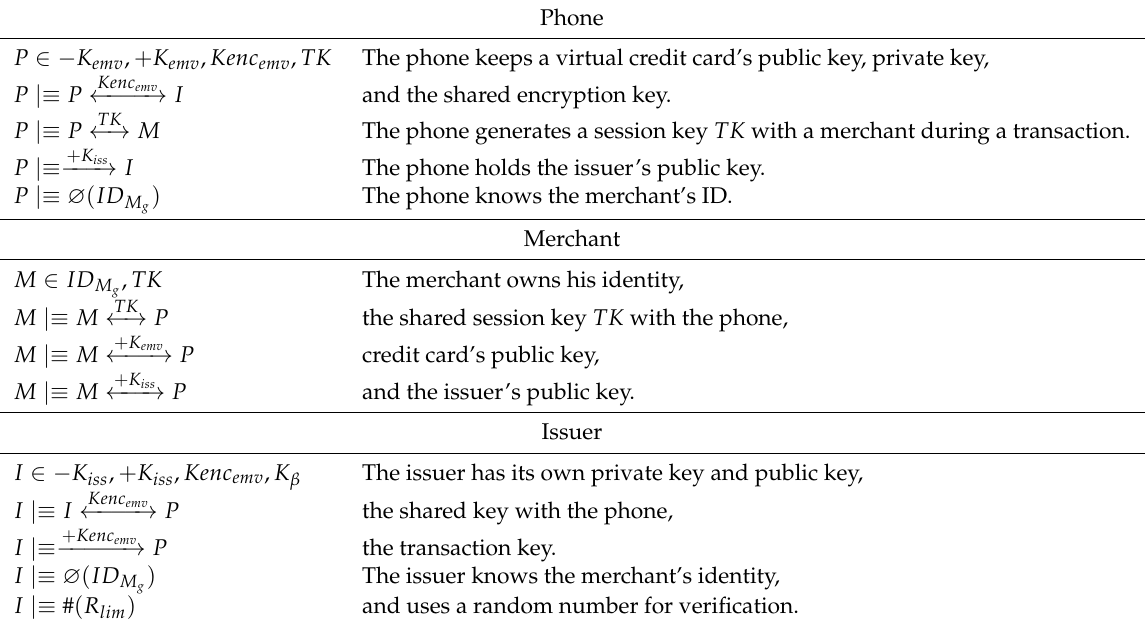
Table 4. Initial assumptions.